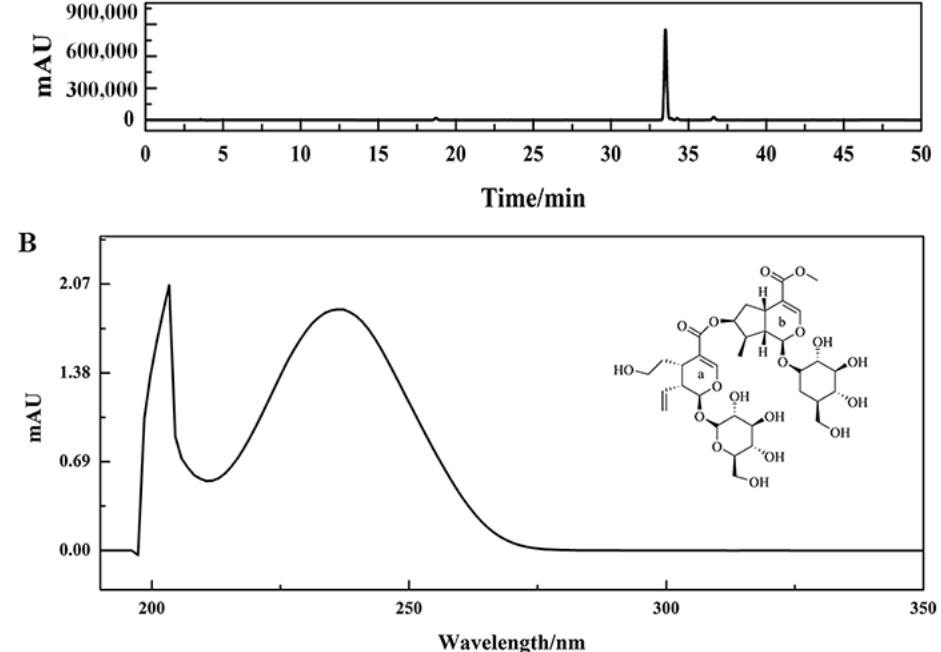
Figure 7. The purity analysis of isolated potential COX-2 inhibitor using the Odyssil C18 analysis column ( A ). Condition: mobile phase A: 0.2% v / v formic acid/water, B: ACN; gradient: 0–50 min, 5–35% B; monitoring wavelength: 254 nm; flow rate: 1.00 mL/min. The ultraviolet-visible absorption spectrum and chemical structure of potential COX-2 inhibitor ( B